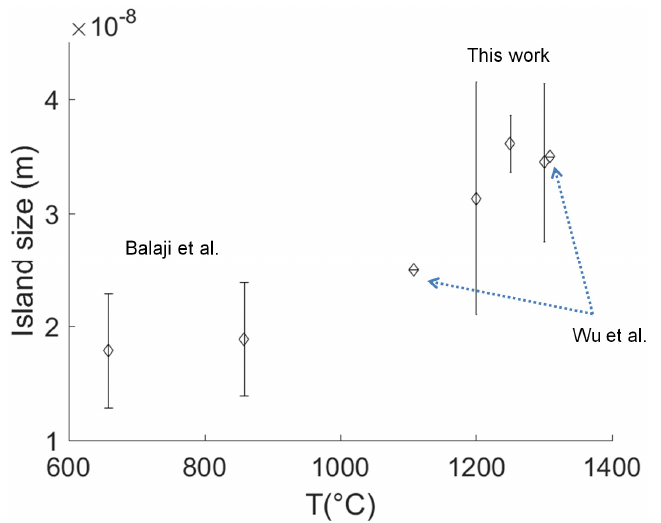
Figure 6. Nucleation island sizes versus temperature from references [13,48,55] and averaged from this work. Standard deviation is indicated when possible to